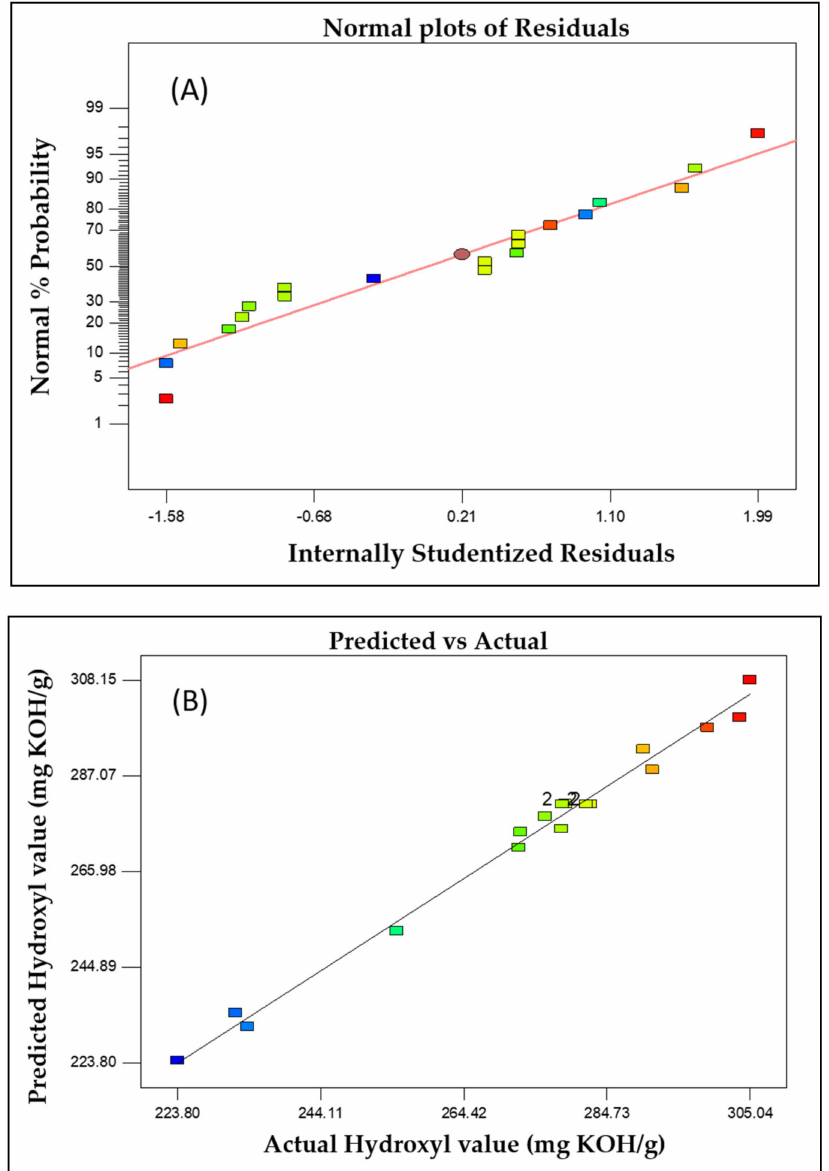
Figure 5. ( A ) The residual plot of experimental runs from central composite rotatable design (CCRD) and ( B ) scatter plot of predicted hydroxyl value (mg KOH/g) versus actual hydroxyl value (mg